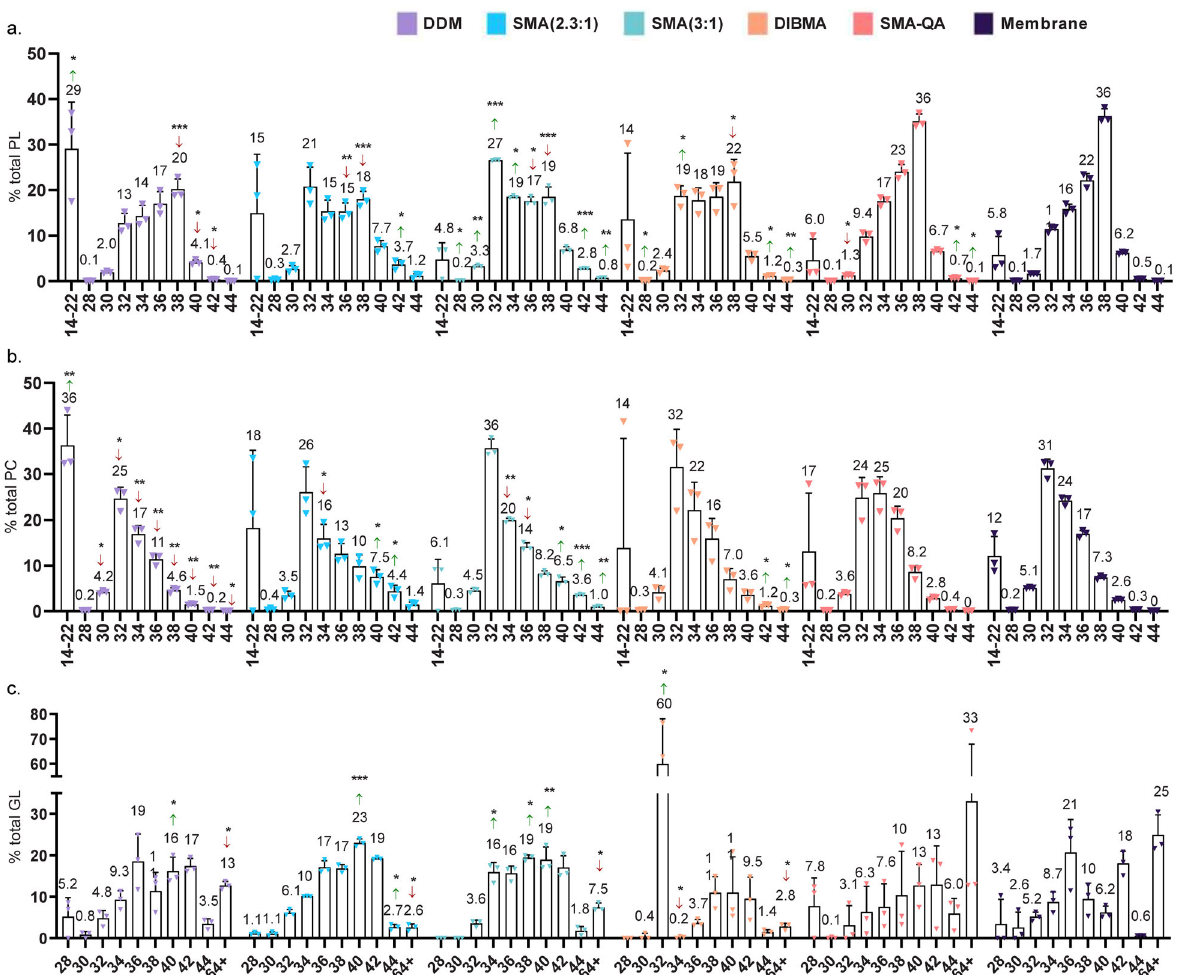
Fig. 5 Fatty acid chain length of solubilized membranes and membrane pellet of Jurkat cells analyzed by LC-MS/MS. Distribution of carbon atoms present in FA chains of a all PL species, b PC species, and c GL species from Jurkat solubilized membranes and membrane pellet. The PC length pro fi les observed for the solubilized samples largely resemble to that of the membrane, with some differences observed for the detergent sample that was enriched in PC species with 4 – 6 and ≥ 8 double bonds and depleted of 1 – 2 and 7 double bonds. Contrarily, the unmodi fi ed SMA samples were enriched in 6 and more double bond PC species and SMA(2.3:1) depleted of saturated and monounsaturated PC lipids. In general, the differences seen in total PL are therefore a result of the distinct headgroup composition of the samples. Data points correspond to three technical replicates, except for technical duplicates for SMA-QA. Error bars represent ±S.D. Signi fi cant differences (upon one-way ANOVA) are denoted as * p < 0.05, ** p < 0.01, *** p <